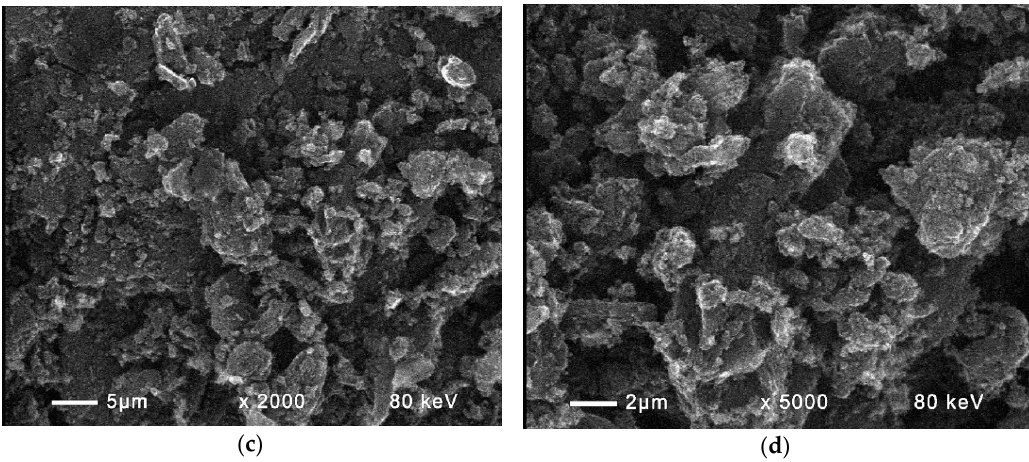
Figure 3. SEM images at different magnifications of granulated activated carbon used in the cathode area. ( a ) Magnification ×500; ( b ) magnification ×1000; ( c ) magnification ×2000; ( d ) magnification ×5000.